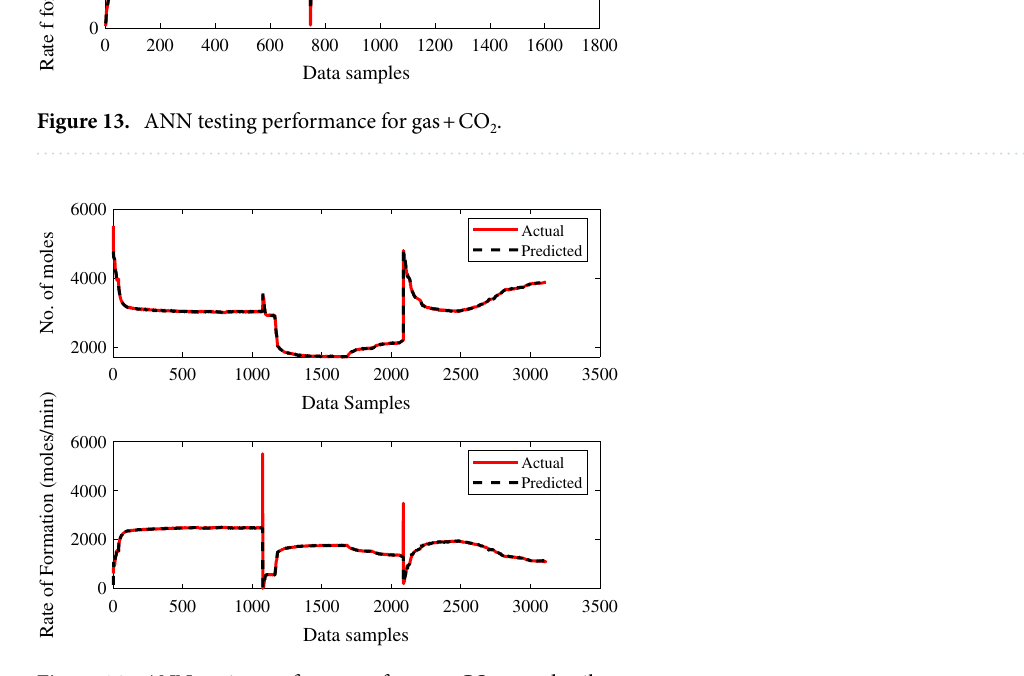
Figure 14. ANN testing performance for gas + CO 2 + crude